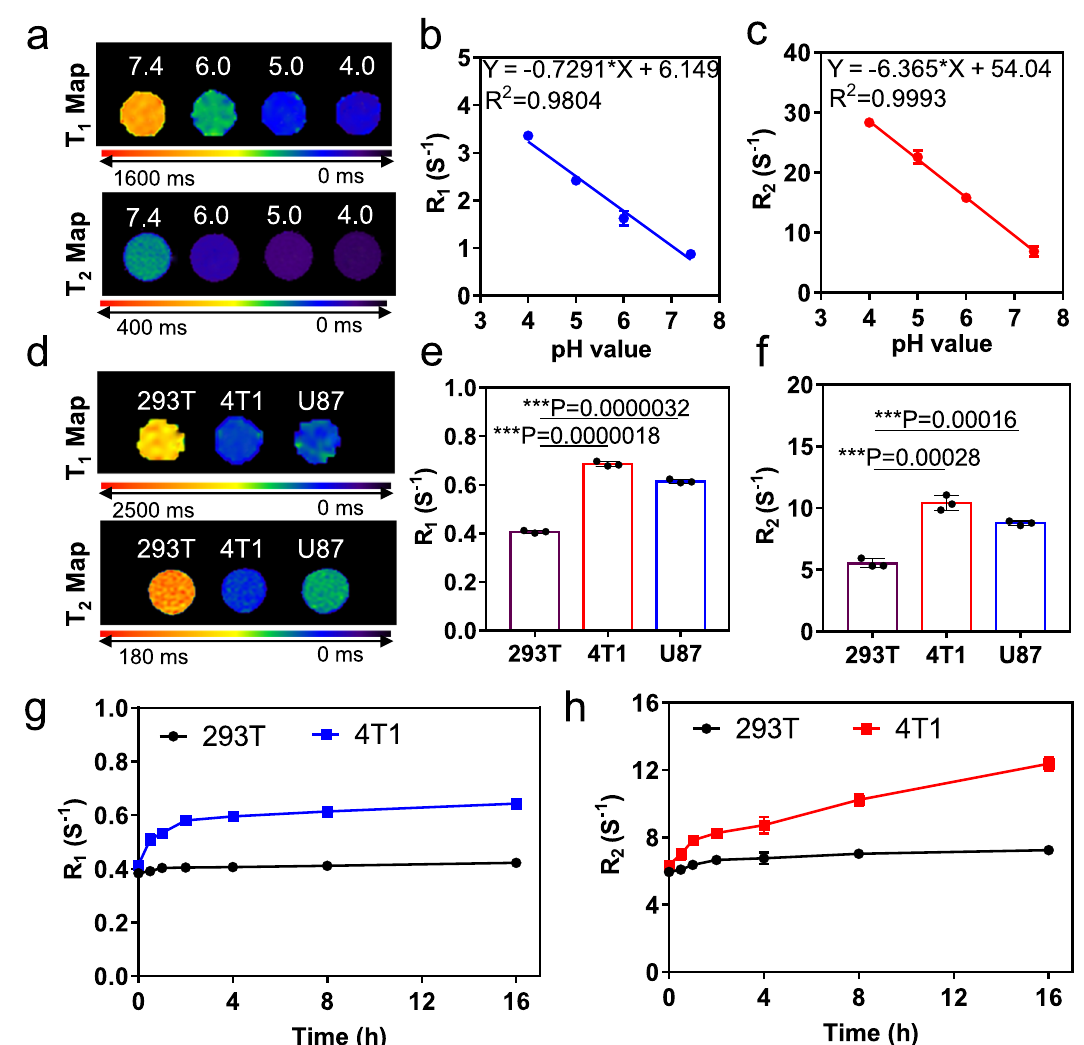
Fig. 4 | Capability of SSM (SPIO@SiO 2 @MnO 2 ) in pH discrimination between normal and cancer cells. a T 1 Map and T 2 Map of SSM in different pH environ- ments (pH = 7.4, 6.0, 5.0, and 4.0). Representative data are shown from three independentsamples. b R 1 and c R 2 ofSSMindifferentpHenvironments(pH=7.4, 6.0, 5.0, and 4.0). Data are presented as mean±SD from three independent sam- ples. d T 1 MapandT 2 Mapofdifferentcelllines(293T,4T1,andU87)incubatedwith SSM.Representativedataareshownfromthreeindependentsamples. e R 1 and f R 2